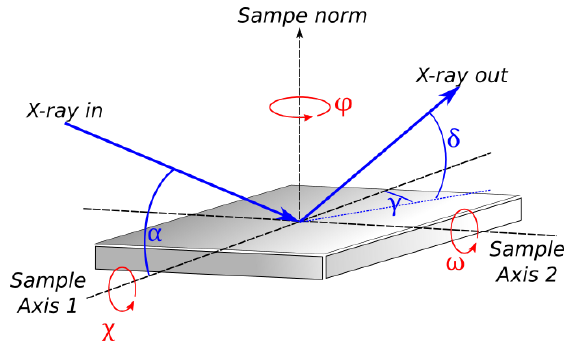
Figure 3. Axes and angles in an XRD measurement. Let Sample axis 1 be the projection of the incoming X-ray on the sample surface, and Sample axis 2 be the axis perpendicular to sample axis 1 and the sample norm. X-ray incident angle ( α ) and in-plane exit angle ( γ ) are measured from sample axis 1. X-ray out-of-plane exit angle ( δ ) is measured from the sample surface. Sample rotation around its norm ( ϕ ) is typically measured from the direction of incident X-ray along sample axis 1. Sample rotation around the axis perpendicular to its norm ( χ ) is measured from sample norm. Note that − 90 ◦ < χ < 90 ◦ . Please also note that rotation around sample axis 2 is measured from the sample norm and is known as ω